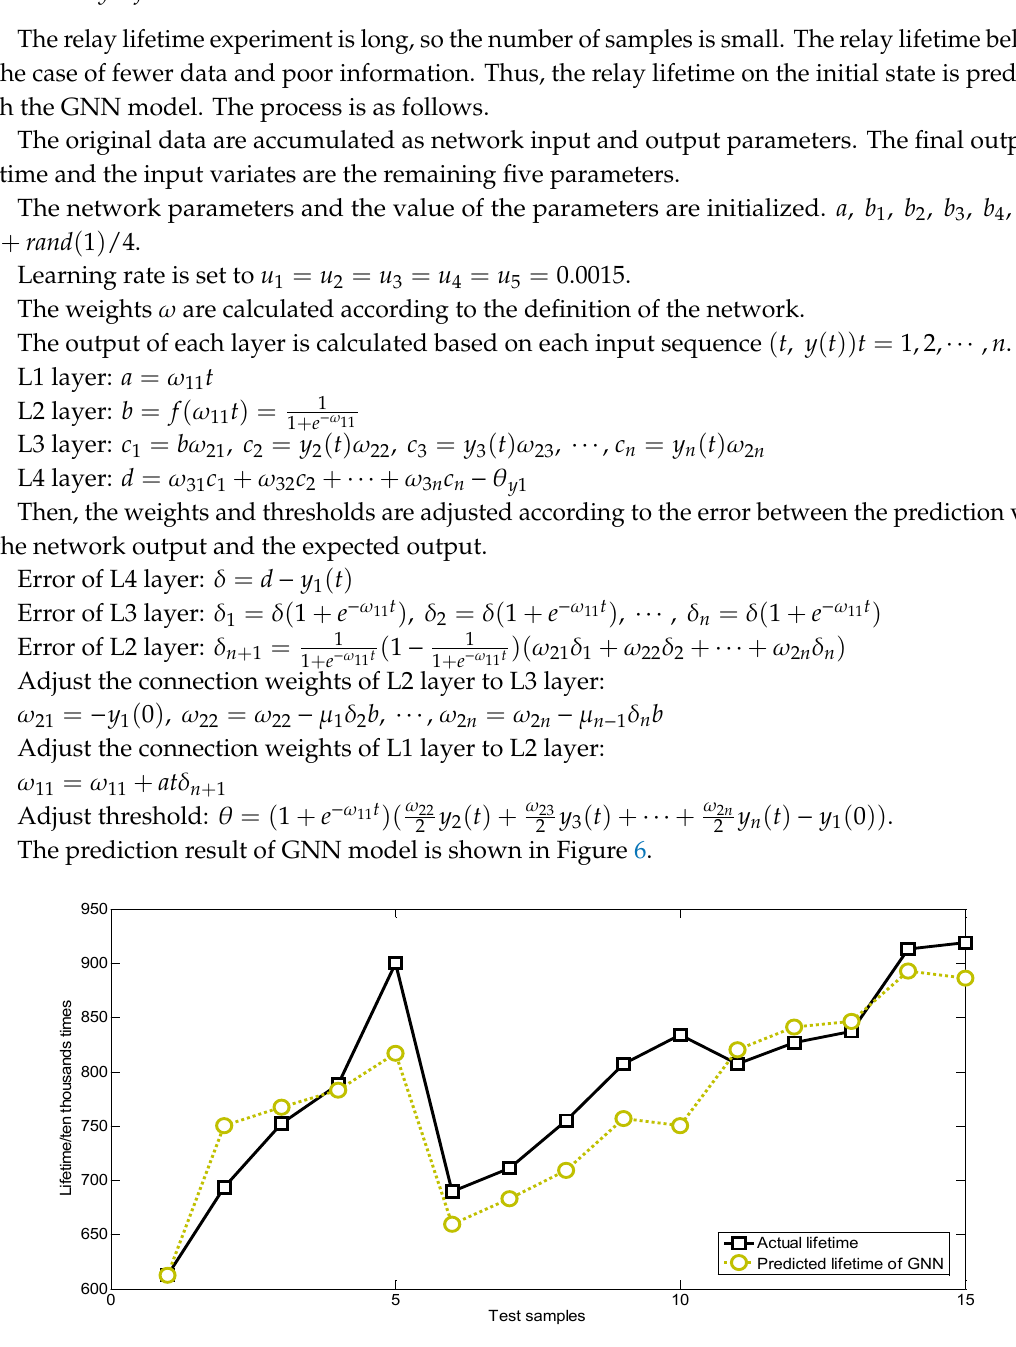
Figure 6. The comparison of actual value with prediction value using GNN model.